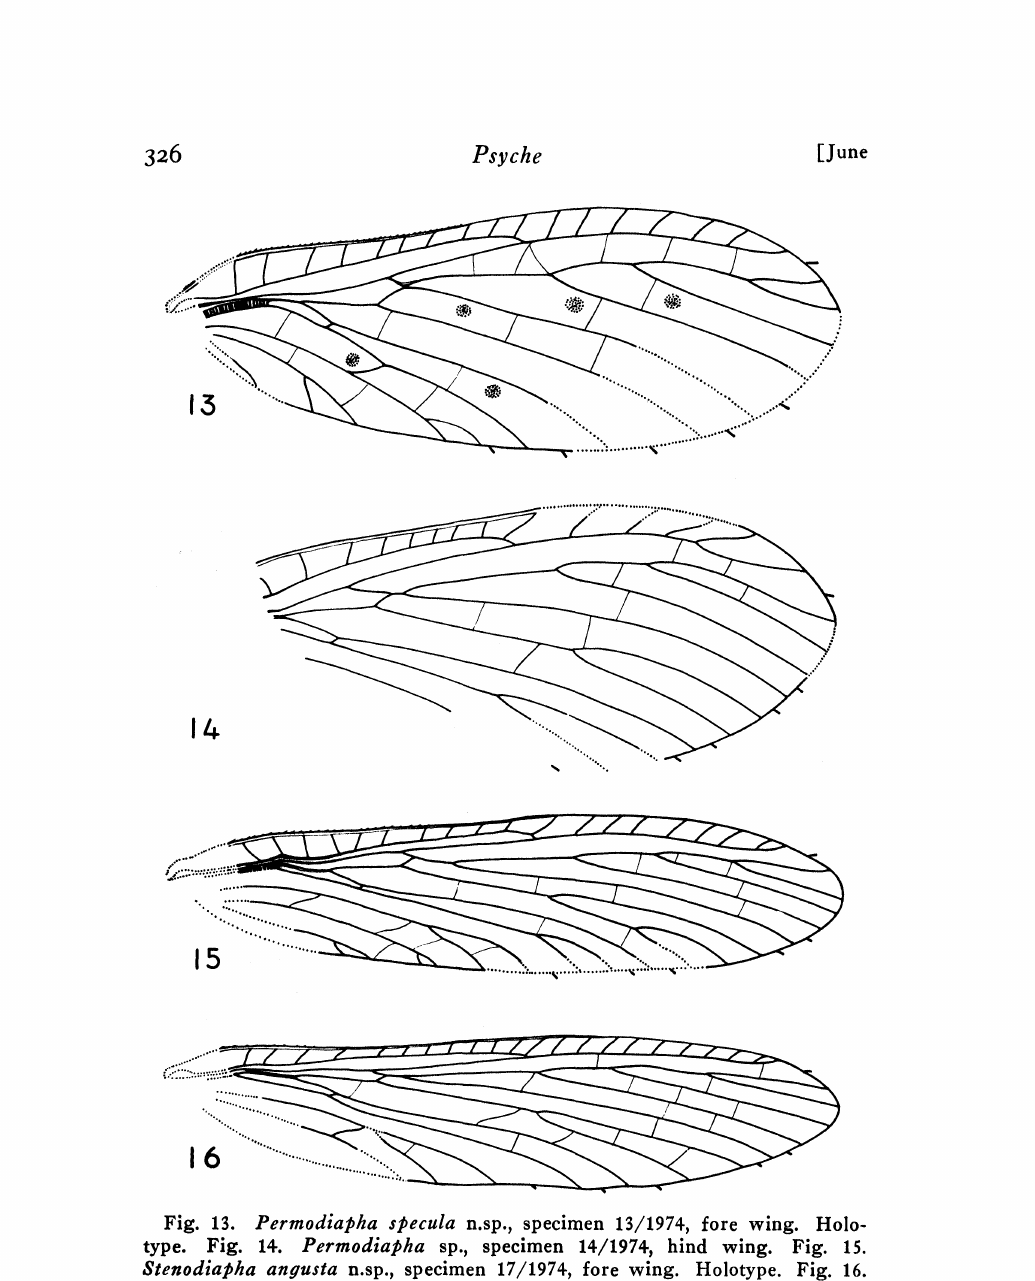
Fig. 13. Permodiapha s#ecula n.sp., specimen 13/1974, fore wing. Holo- type. Fig. 14. Permodia#ha sp., specimen 14/1974, hind wing. Fig. 15. Stenodia#ha angusta n.sp., specimen 17/1974, fore wing. Holotype. Fig. 16. 8tenodiatha anguata n.sp., specimen 18/1974, fore